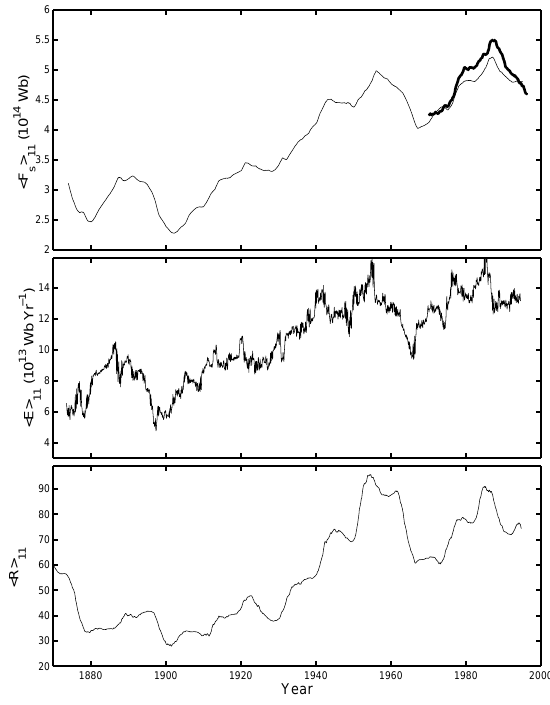
Fig. 4. Variations of 11-year running means: (top) of the open flux < [ F s ] aa > 11 derived from the aa index (thin line) and from near- Earth IMF observations (thick line); (middle panel) of the emer- gence rate <E> 11 derived from [ F s ] aa from the aa index with a linear loss rate of open flux with the best-fit time constant of τ = 3 . 6 years; (bottom) of the sunspot number <R> 11